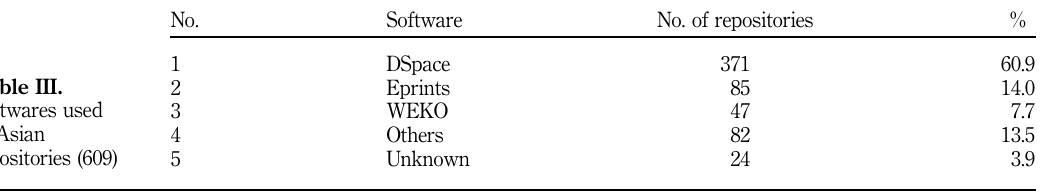
Table IV. Open source softwares usage in Malaysia